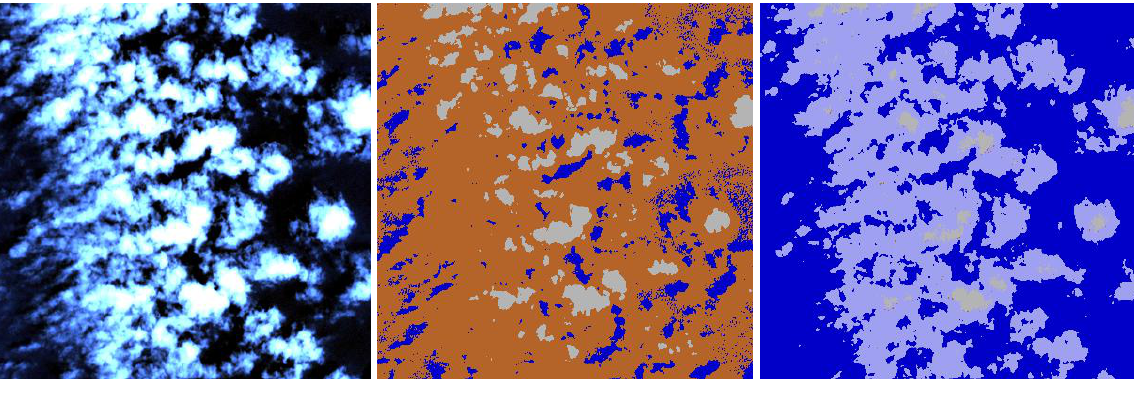
Figure 8 . Water and cloud over water (area with label 3 of Figure